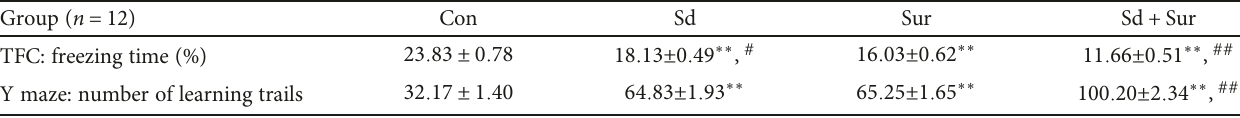
Table 1: Analysis of freezing time in TFC and number of learning trails in the Y maze test. Group ( n = 12 )